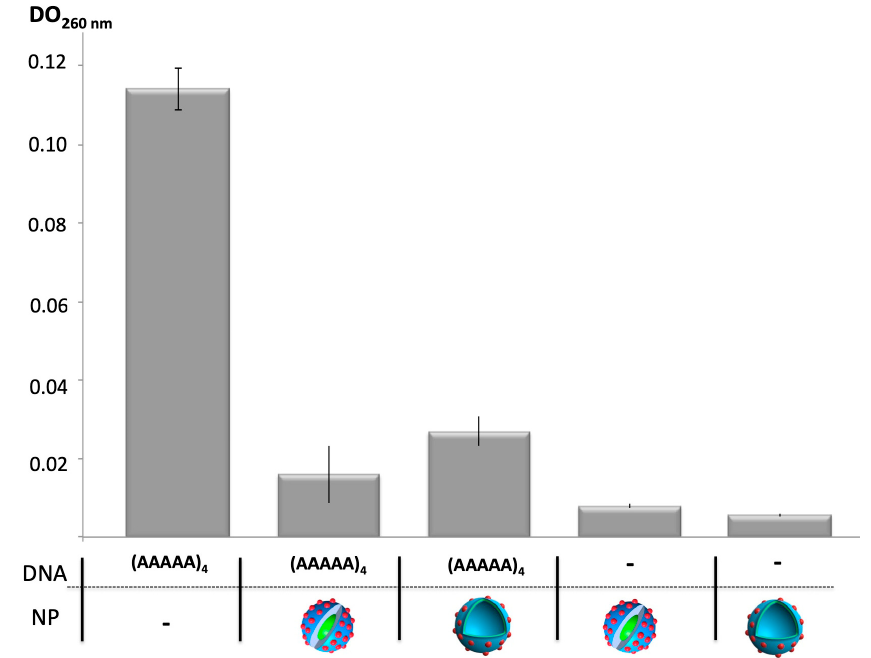
Figure 5. DNA binding experiments involving oligoA DNA sequences (DNA) and nanoparticles (NP) (DO measured at 260 nm and after ultrafiltration). Control experiments containing only oligo A (left) or only nanomaterials (right) are also depicted (NP: red dots depict the T nucleobases).